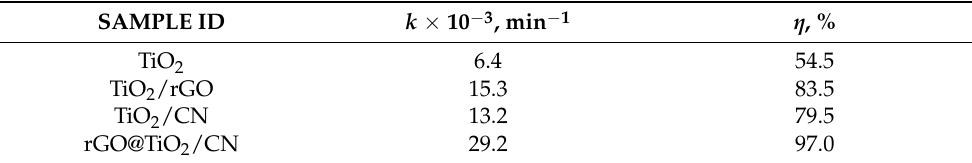
Table 2. The values of the first-order rate constant ( k ) and efficiency ( η ) of RhB dye aqueous solution photodegradation by prepared